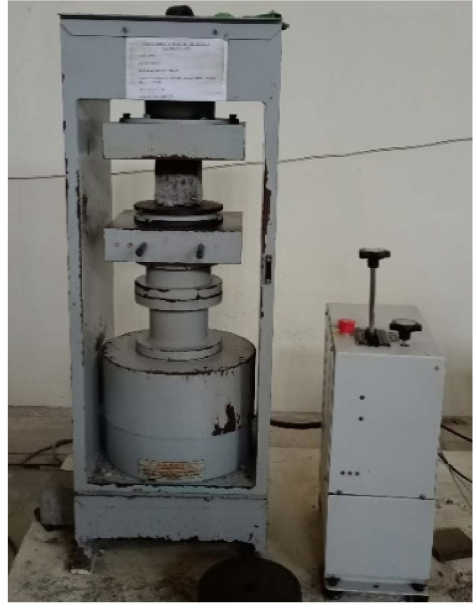
Figure 6. Compression testing machine.